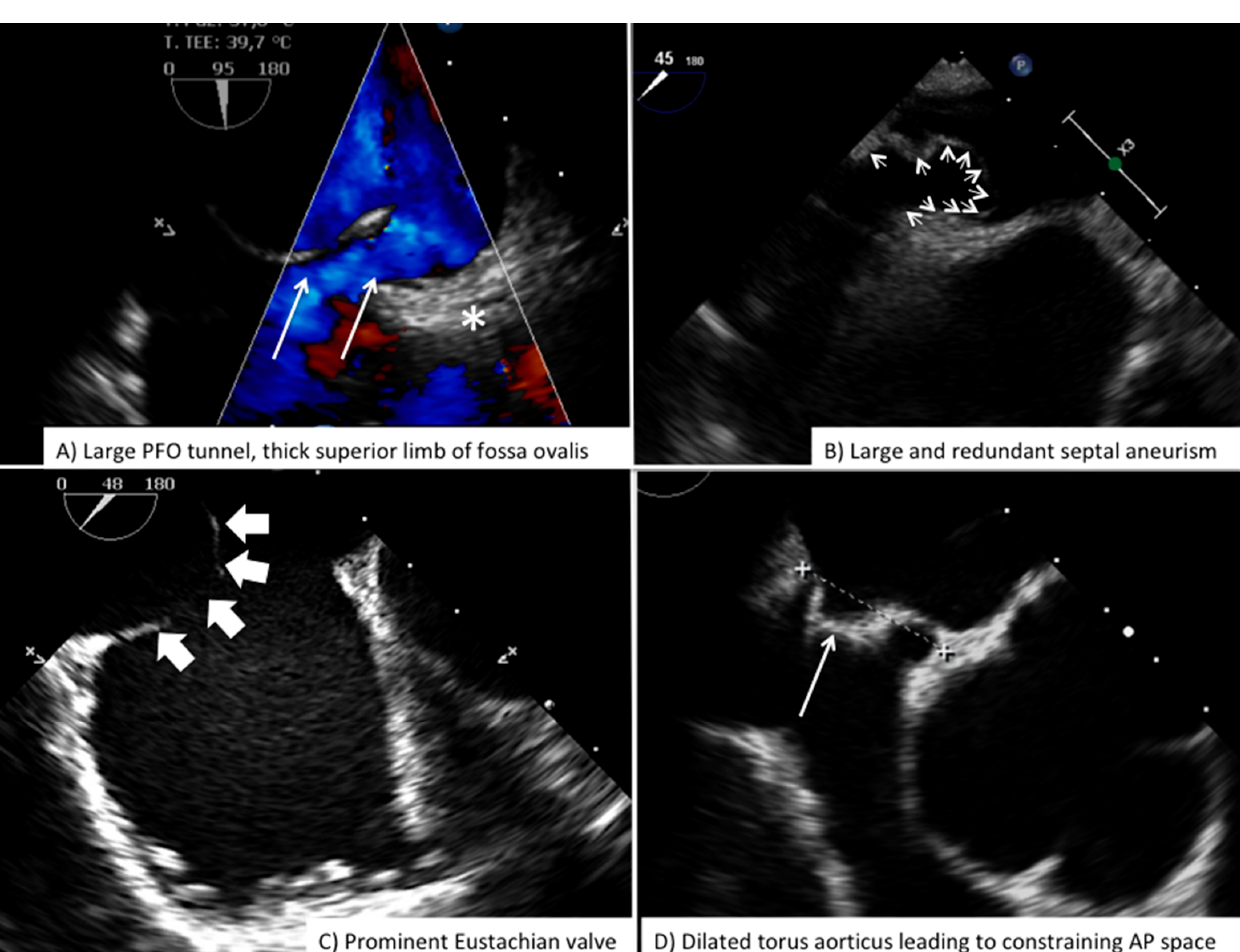
Figure 6. Challenging anatomies for PFO closure. Common anatomical features increasing procedural complexity and complication during PFO closure. PFO = Patent Foramen Ovale.